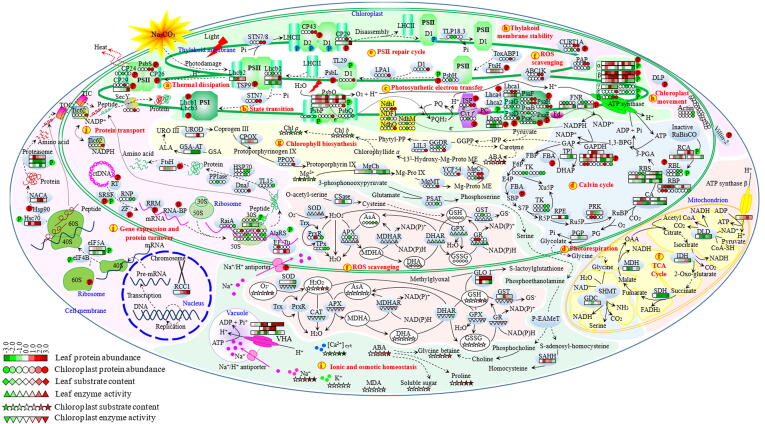
Homology based structural models of the chloroplast phosphoproteins from alkaligrass The ribbon images of A–D, F, G, and I–N are generated by SWISS-MODEL program based on the comparative protein structure modeling approach, and the 3D models based on their own amino acid sequences. While images of E and H are the experimentally resolved 3D structure that has a significant amino acid sequence similarity to our phosphoproteomic identified sequence by searching the SWISS-MODEL template library. By using the Swiss-PdbViewer (version 3.7), the phosphorylation sites are shown with balls in red (enhanced phosphorylation) and green (inhibited phosphorylation). Domains from the phosphoprotein are highlighted in different colors. A. Lhca2, light-harvesting chlorophyll a/b binding protein of LHCI type II (PDB ID: 4xk8). B. Lhca4, photosystem I light-harvesting complex type 4 protein (PDB ID: 4y28). C. Lhcb1, chlorophyll a/b binding protein of LHCII type 1 (PDB ID: 1rwt). D. PsbS, photosystem II subunit S (PDB ID: 4ri2). E. PsbO, oxygen-evolving enhancer protein 1 (PDB ID: 3jcu). F. TL29, thylakoid lumenal 29 kDa protein (PDB ID: 3rrw). G. PsaC, photosystem I subunit VII (PDB ID: 4y28). H. PsaD, photosystem I reaction center subunit II (PDB ID: 2wsc). I. PsaE, photosystem I reaction center subunit IV (I and II representing two protein species of PsaE) (PDB ID: 4y28). J. Cyt f, cytochrome f (PDB ID: 1q90). K. FNR, ferredoxin-NADP reductase (PDB ID: 1qg0). L. ATP synthase alpha subunit (PDB ID: 5cdf). M. ATP synthase beta subunit (PDB ID: 1fx0). N. PDH, pyruvate dehydrogenase E1 component subunit alpha (PDB ID: 1ni4). Detailed information can be found in Table S12.